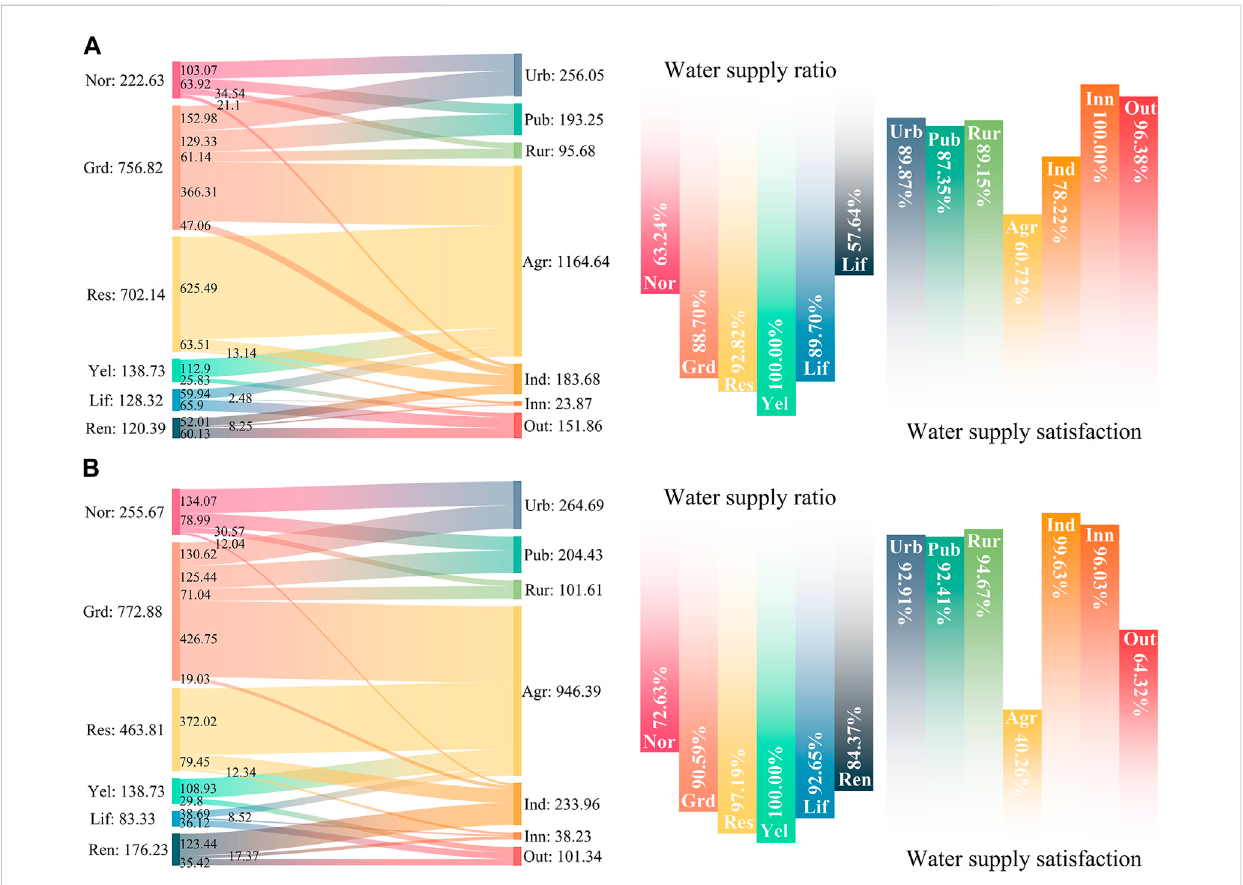
FIGURE 10 The results of optimal allocation of water resources in Handan in normal and low fl ow year (10 6 m 3 ). (A) Normal year (B) Low fl ow